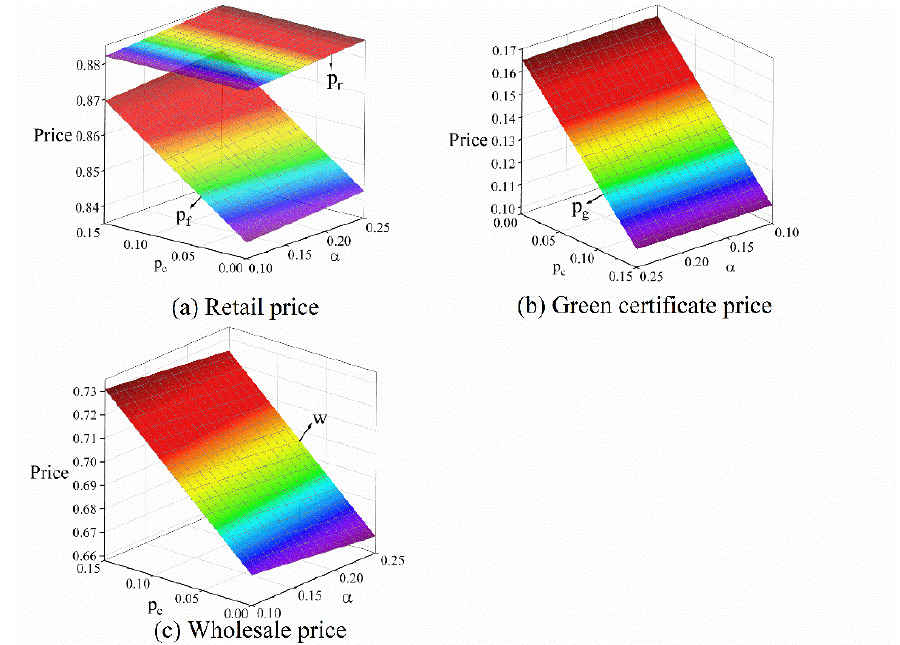
p . 365 Figure 10. The trend of the price under different levels of α and p c c